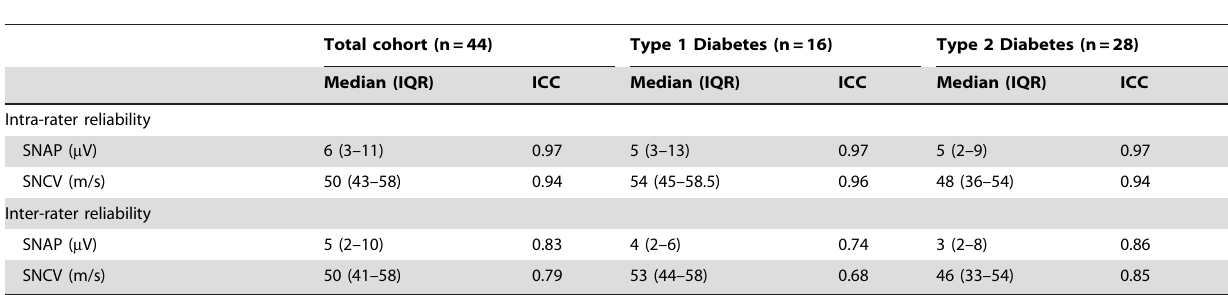
Table 2. Intra- and interrater reliability of the sural nerve amplitude potential and conduction velocity using the point-of-care device for 44 subjects with type 1 and type 2